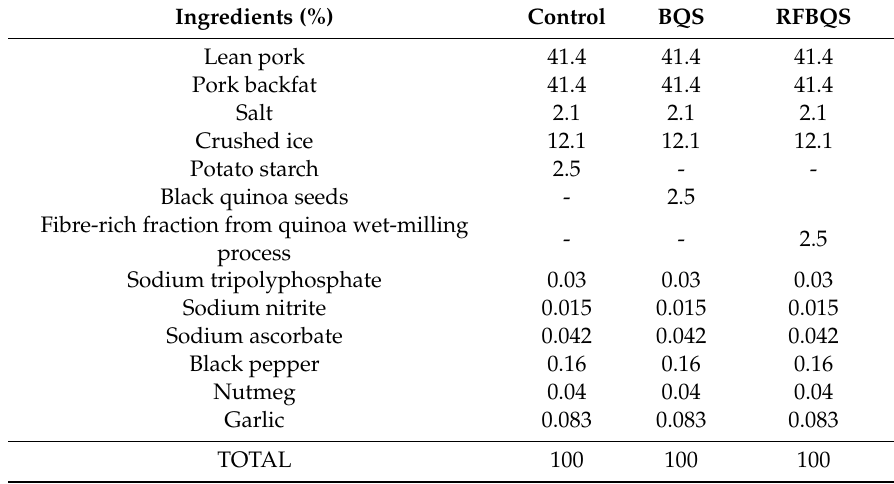
Table 1. Formulation of Bologna-type sausages containing quinoa products (black quinoa seeds (BQS) and the fibre-rich fraction from its wet-milling process